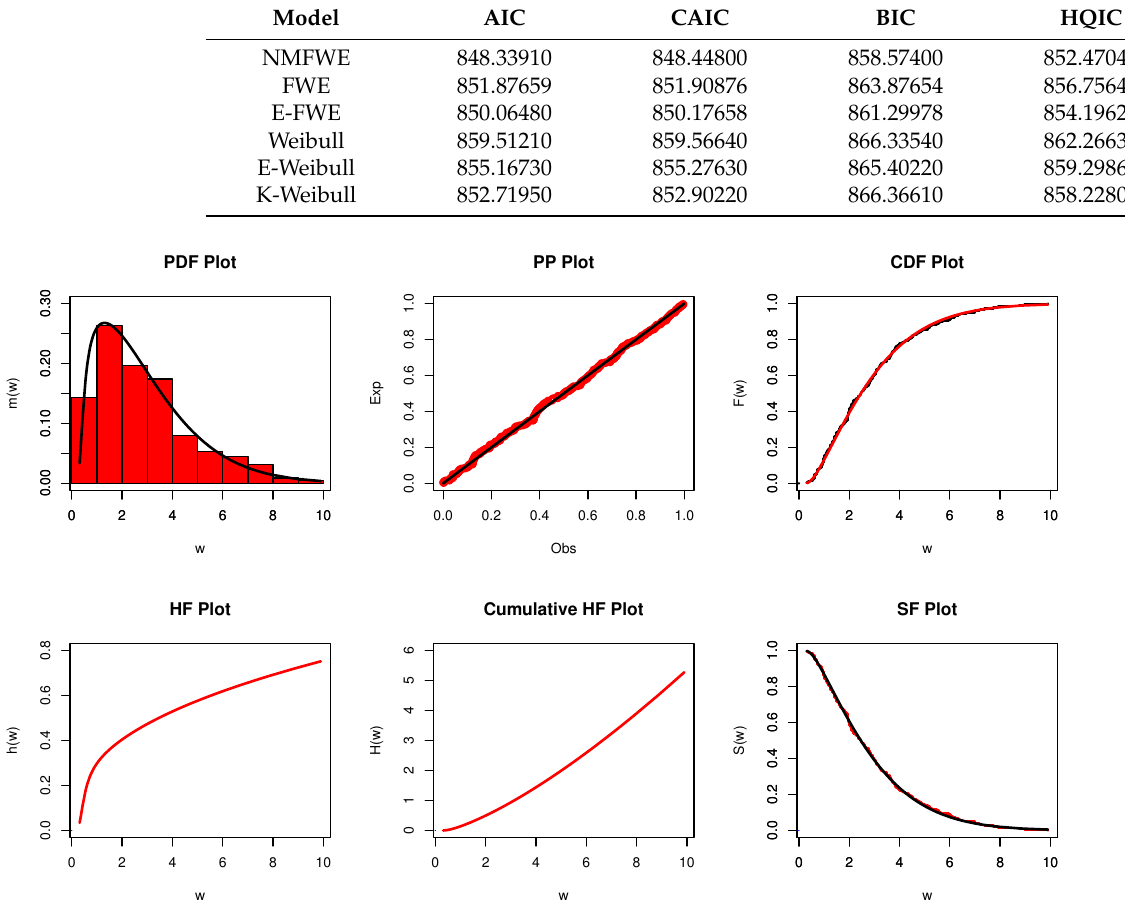
Figure 7. A visual illustration of the NMFWE model using Data